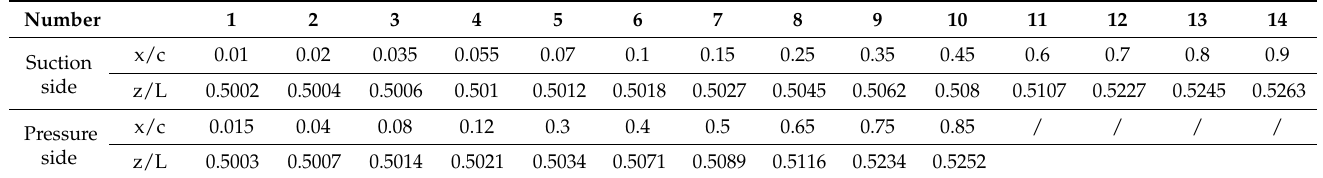
Figure 2. Model design schematic diagram. Table 1. Distribution of pressure taps on airfoil